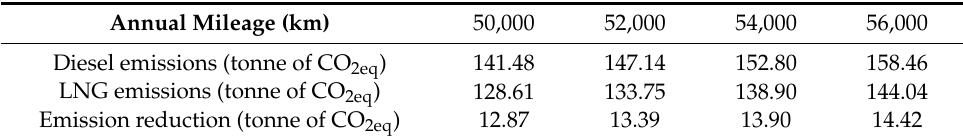
Table 7. Annual LNG truck GHG emission reduction.